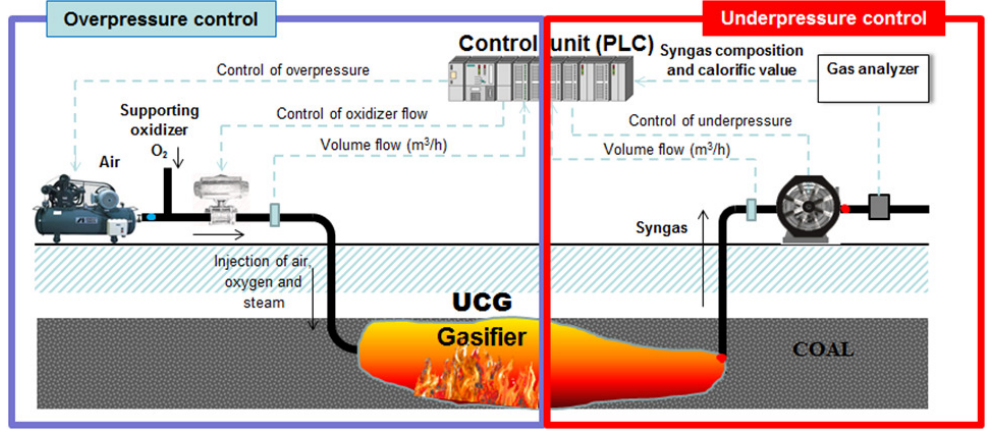
Figure 1. Basic control approaches on stabilization level